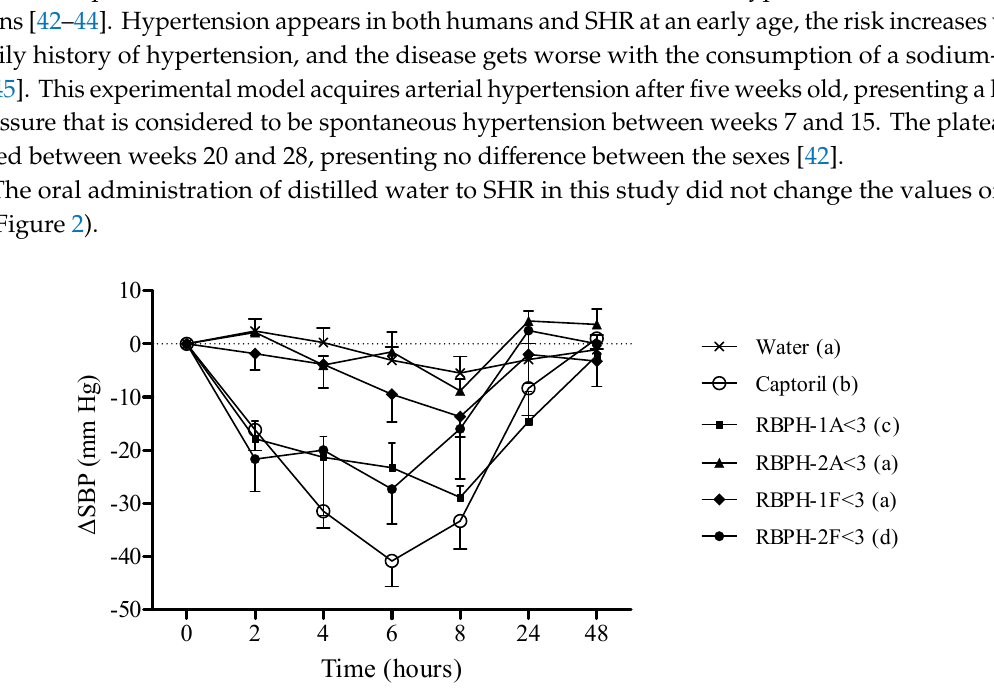
Figure 2. Decrease in systolic blood pressure (SBP) caused in spontaneously hypertensive rats (SHR) after the oral administration of water (x), Captopril (50 mg/kg) ( ◌ ), or 80 mg/kg of the rice bran protein hydrolysate fractions with a molecular mass smaller than 3 kDa: RBPH-1A<3 ( ■ ), RBPH-2A<3 ( ▲ ), RBPH-1F<3 ( (cid:4608)(cid:4609) ), and RBPH-2F<3 ( ● ). Data are expressed as means ± SEM. The experimental groups always had a minimum of eight animals. The same letters indicate no statistical differences ( p > 0.05). Significance was estimated using two-way ANOVA.